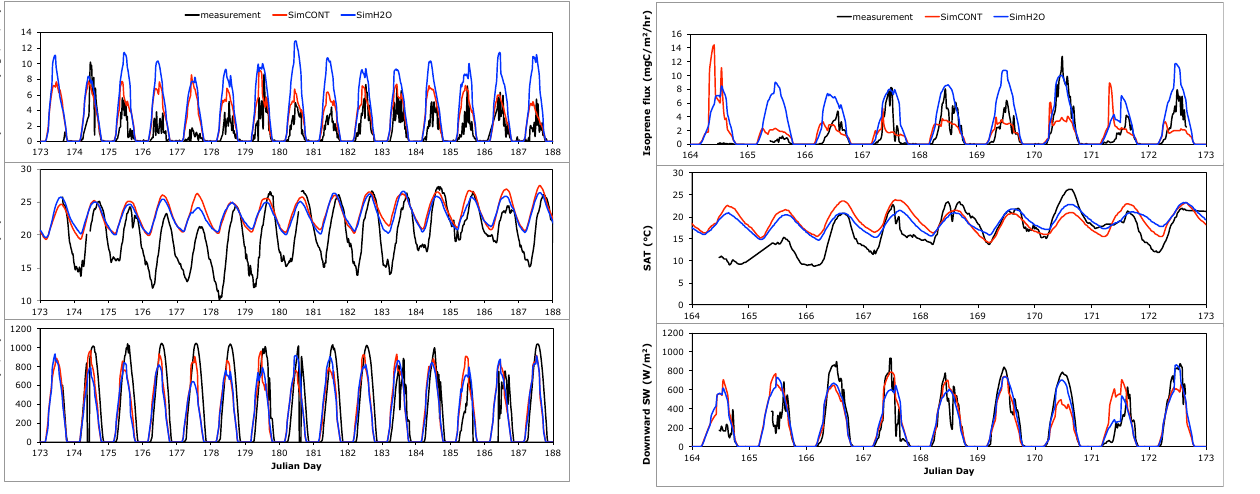
Figure 8. Time evolution of isoprene emission flux, surface air temperature (SAT) and downward shortwave (SW) radiation at the temperate measurement sites. Measurements are shown in black (where data is available). Model climatological results are averages of 10 simulation years for SimCONT (red) and SimH2O (blue). (a) Results for La Verdière during June 21 – July 6 2000.